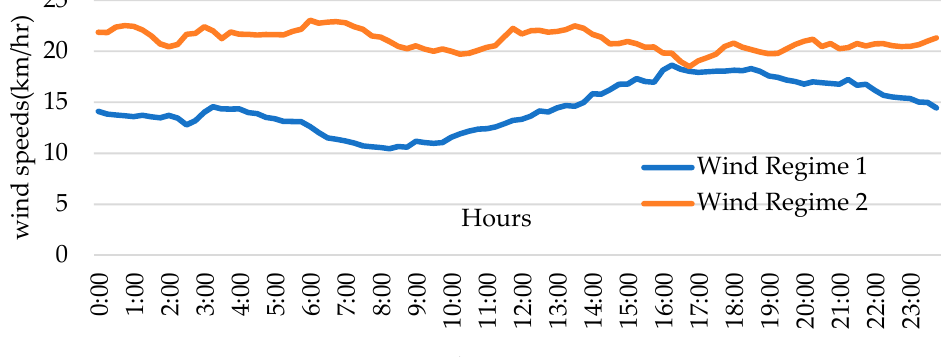
Figure 6. Wind regime variation.